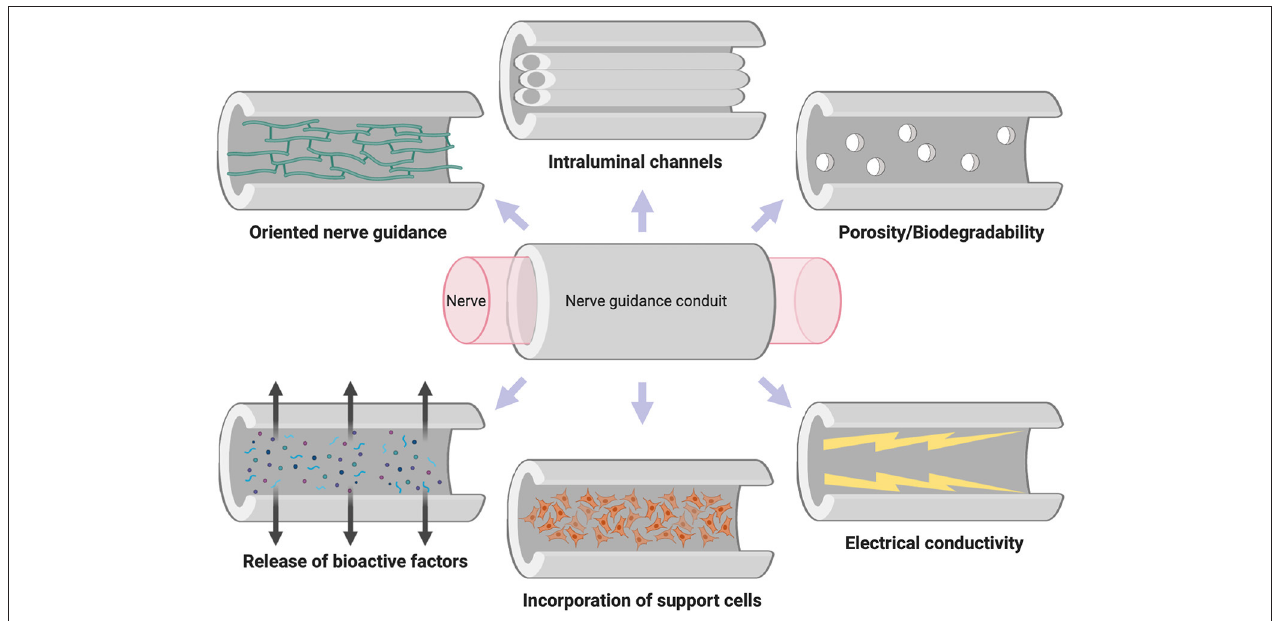
FIGURE 6 | Properties of the ideal nerve guidance